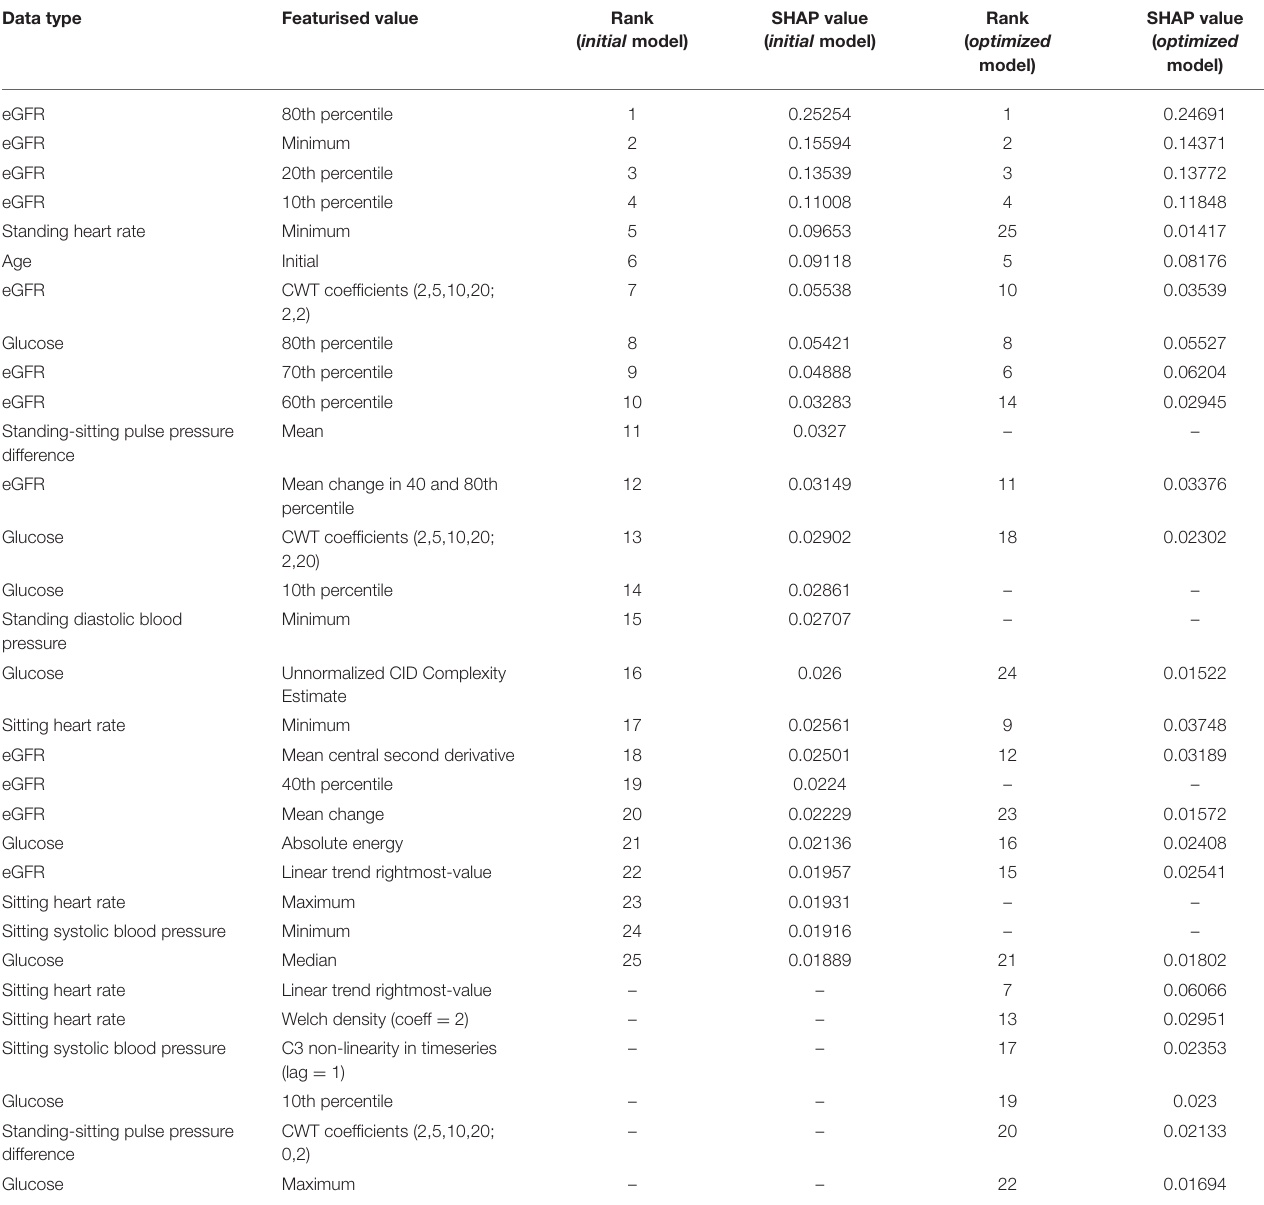
TABLE 2 | The 25 most predictive features of the initial and optimized